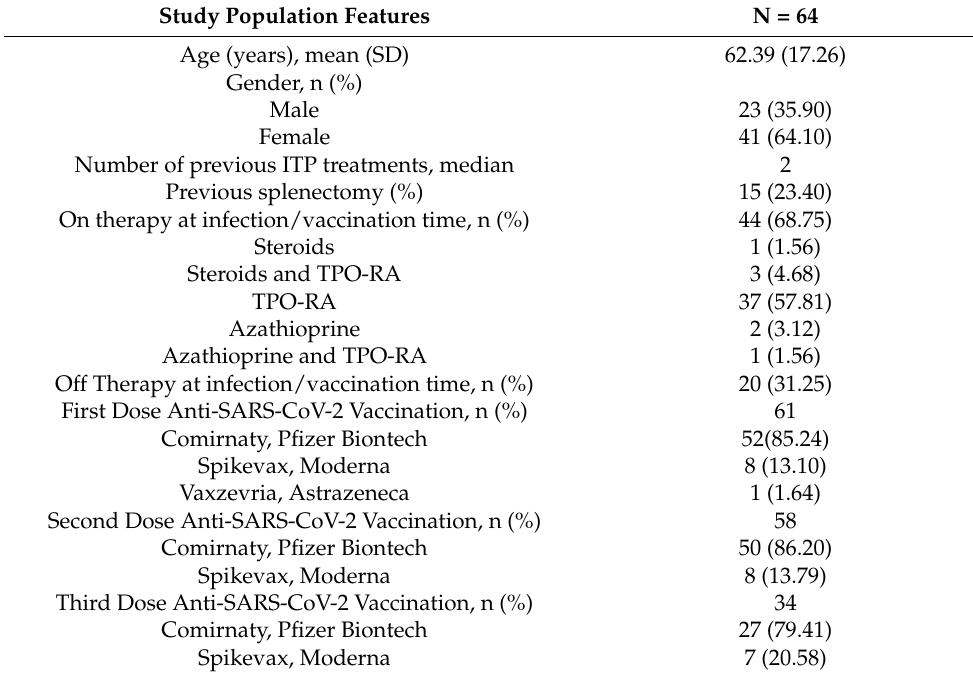
Table 1. Study Population Features . Descriptive statistics of sample features. ITP—Immune Throm- bocytopenic Purpura. TPO-RA—TPO Receptor Agonist. SD—standard